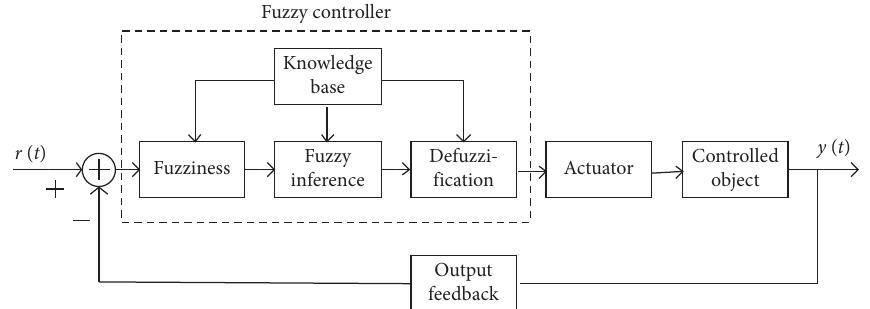
Figure 6: Logic diagram of fuzzy